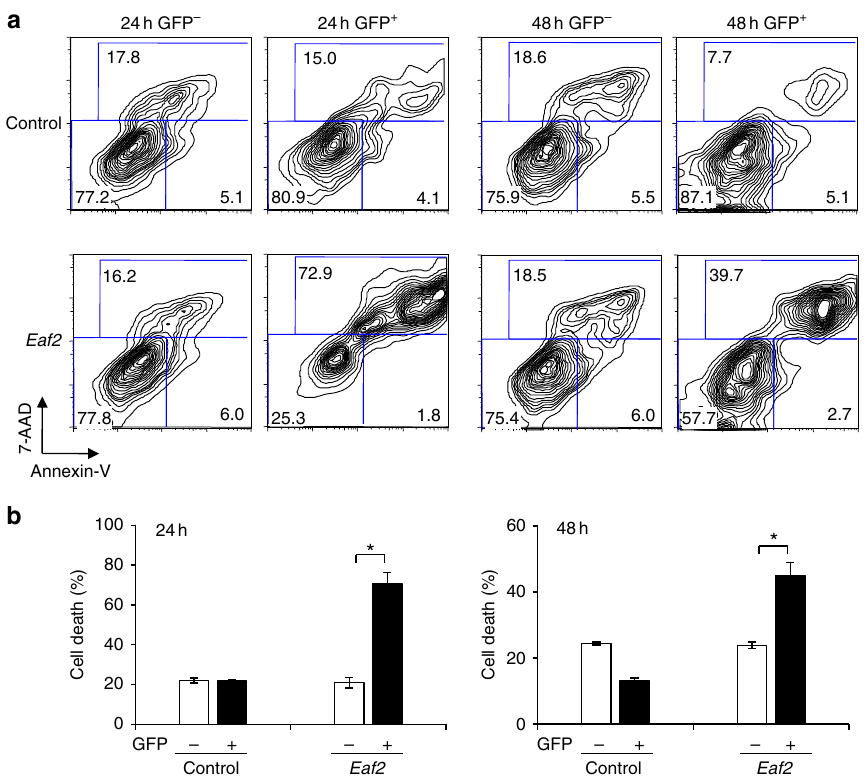
Figure 1 | Overexpression of Eaf2 induces the death of normal B cells. Purified spleen B cells (1 (cid:2) 10 5 per ml) were stimulated with 10 m gml (cid:3) 1 of LPS for 24h and then transduced with retrovirus expressing GFP (control) or EAF2-IRES-GFP (Eaf2). The cells were further cultured for 24 and 48h and analysed for cell death by Annexin-V and 7-AAD staining. ( a ) Representative FACS profiles of B cells cultured for 24 and 48h. ( b ) Percentages of apoptotic (Annexin-V þ 7-AAD (cid:3) ) þ dead (7-AAD þ ) cells in gated GFP (cid:3) and GFP þ population. Summary of the results of three independent experiments. * P o 0.05 (paired t